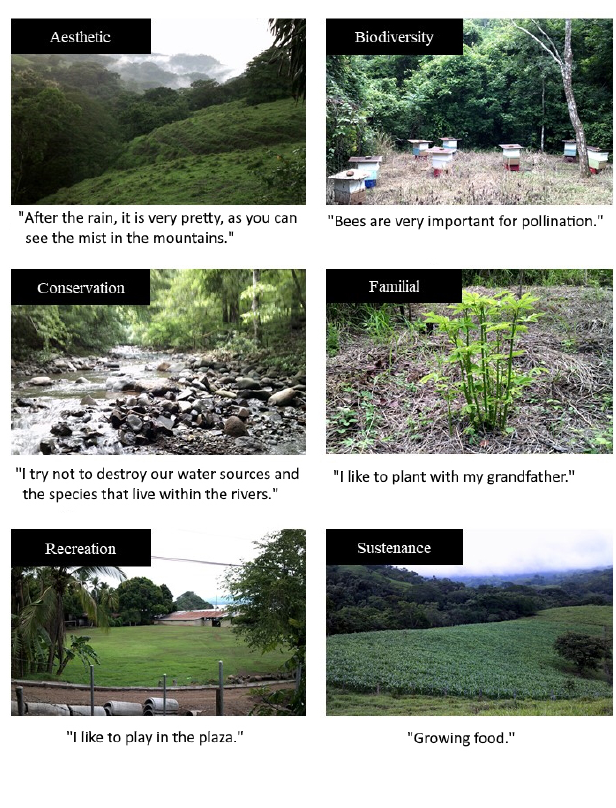
Fig. 2 . Photographic examples of top six values expressed among all participants. Quotations reflect emic descriptions of the value of the photo. Tourism and economic values are not shown because they were expressed by only one community.